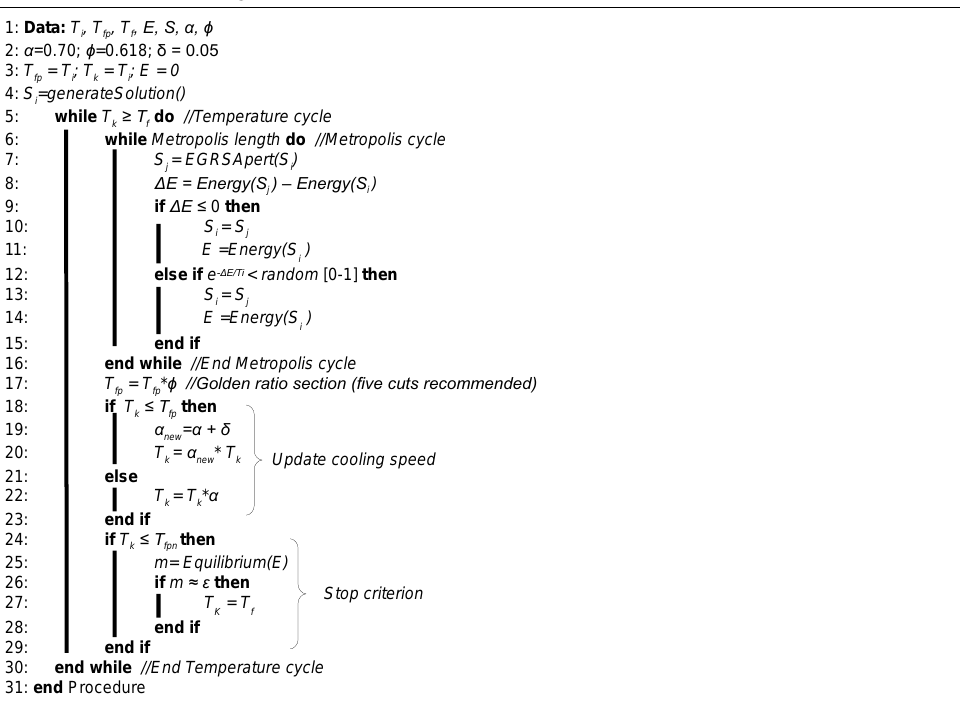
Algorithm 3.1 EGRSApert Function